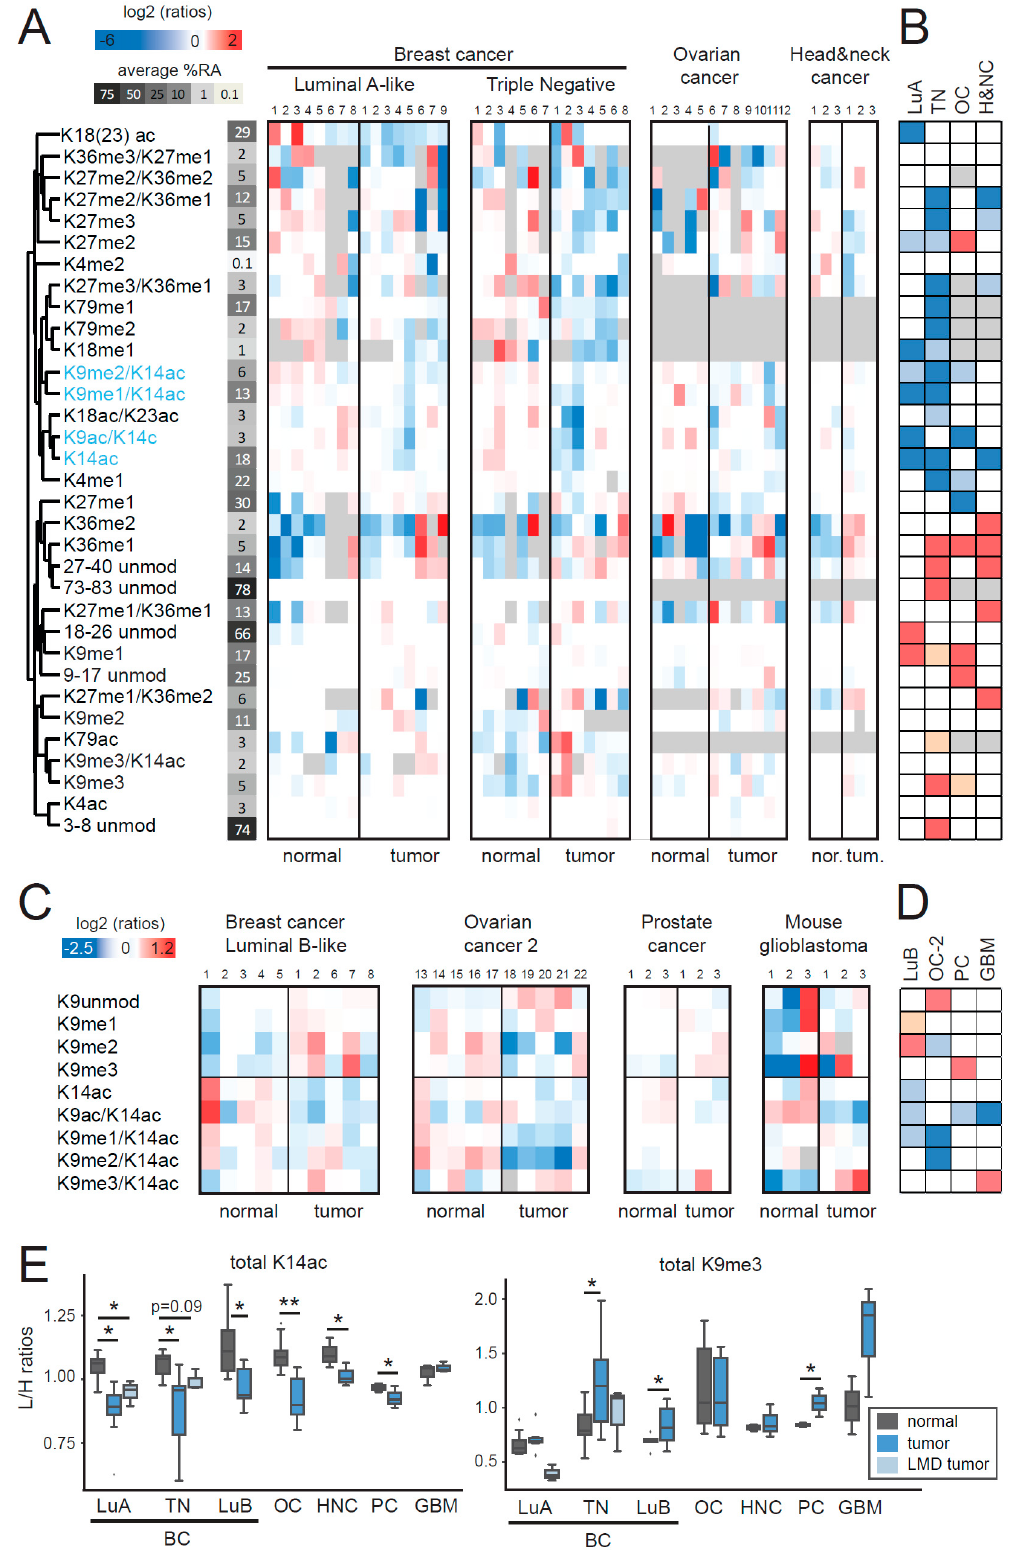
Figure 1. Comparison of histone H3 post-translational modifications (PTMs) in tumor and normal tissues. ( A , C ) Heatmap display and hierarchical clustering of the log2 transformed ratios obtained for the indicated histone H3 (H3) PTMs for di ff erent tumor types. Matched normal and tumor tissues are indicated by the same sample number. L / H (light / heavy) relative abundances ratios obtained with